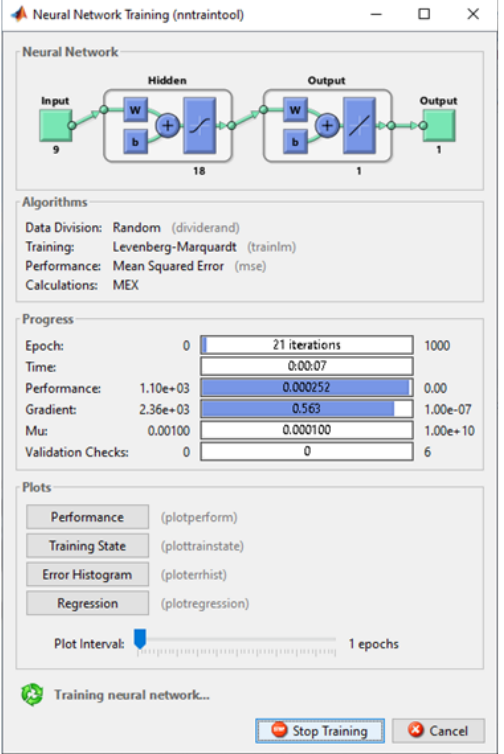
Figure 4. Training process of pure ANN with any optimization.